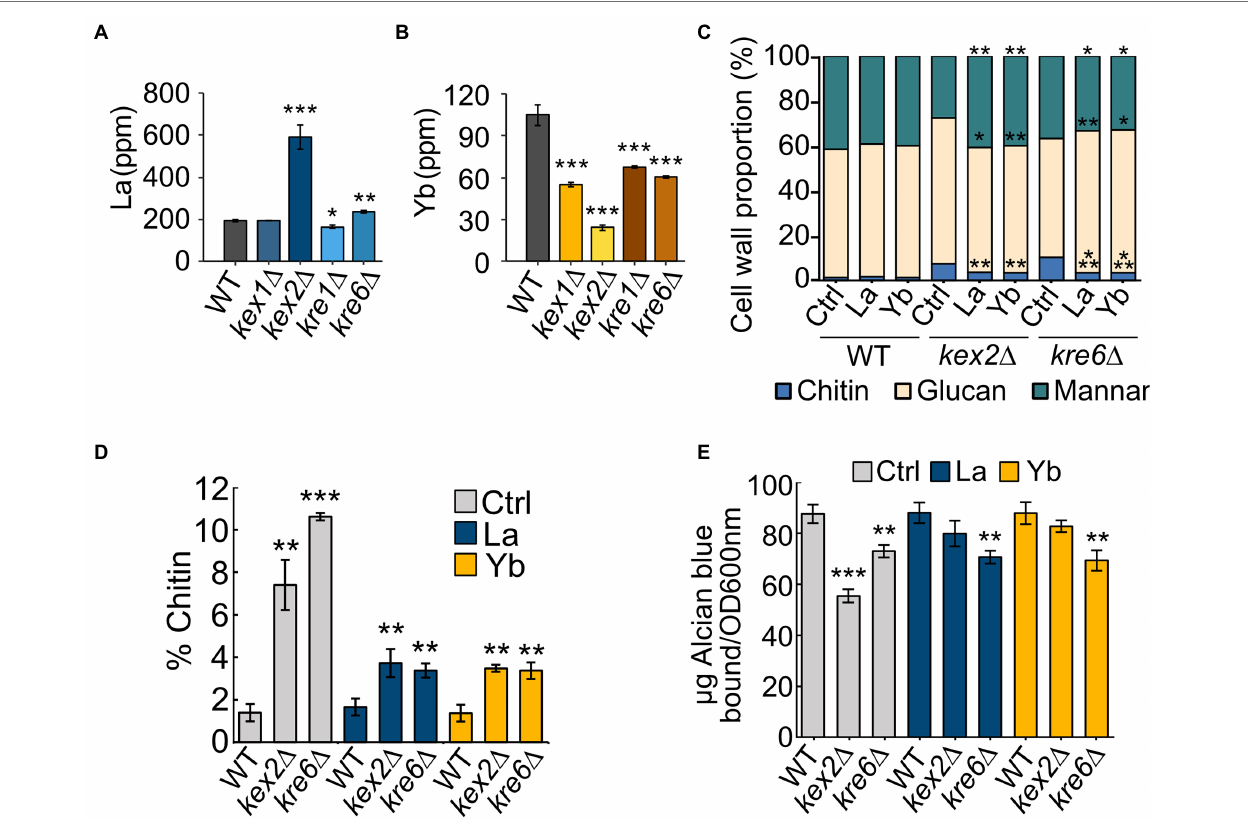
FIGURE 6 | La and Yb concentrations and cell wall composition of WT and mutant strains. (A,B) Cells were grown in modified YNB and exposed to (A) La (50 μ M) or (B) Yb (6 μ M) for one hour. Data are the means (±SD) of three independent cultures. Significant differences from the wild-type condition are indicated by asterisks (ANOVA, Tukey HSD). (C) Cell wall composition of WT, kex2 ∆ , and kre6 ∆ in chitin, glucans, and mannans. Significant differences from control conditions in each strain are indicated by asterisks (t-test). (D) Chitin content in the cell wall of WT, kex2 ∆ , and kre6 ∆ under Ln exposure. Significant differences from the WT strain are indicated by asterisks (t-test). (E) Phosphomannan content using the Alcian blue binding test in each strain. Significant differences from the wild-type strain are indicated by asterisks (t-test). Data are the means (±SD) of three independent cultures. For all experiments: *<0.05, **<0.01, ***<0.001.